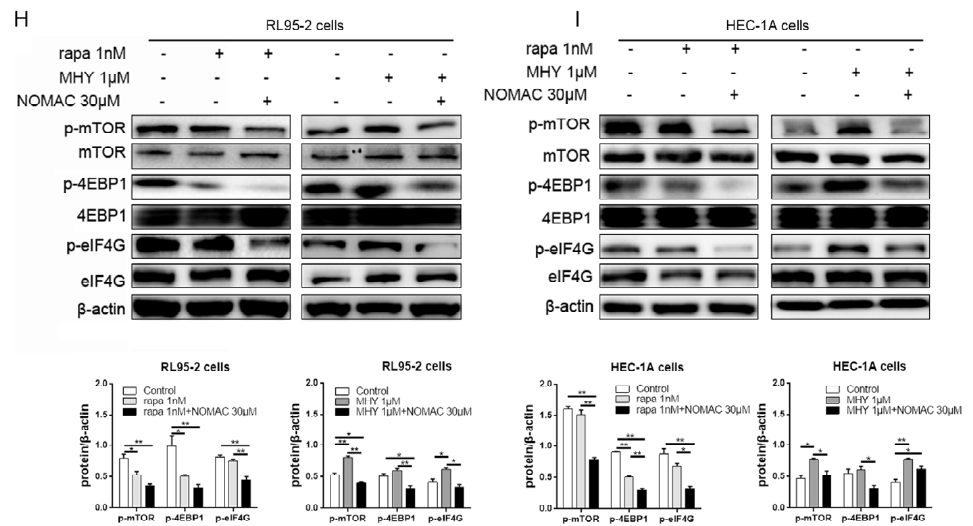
Figure 3. NOMAC induced cell cycle arrest and apoptosis and down-regulated the activity of mTOR–